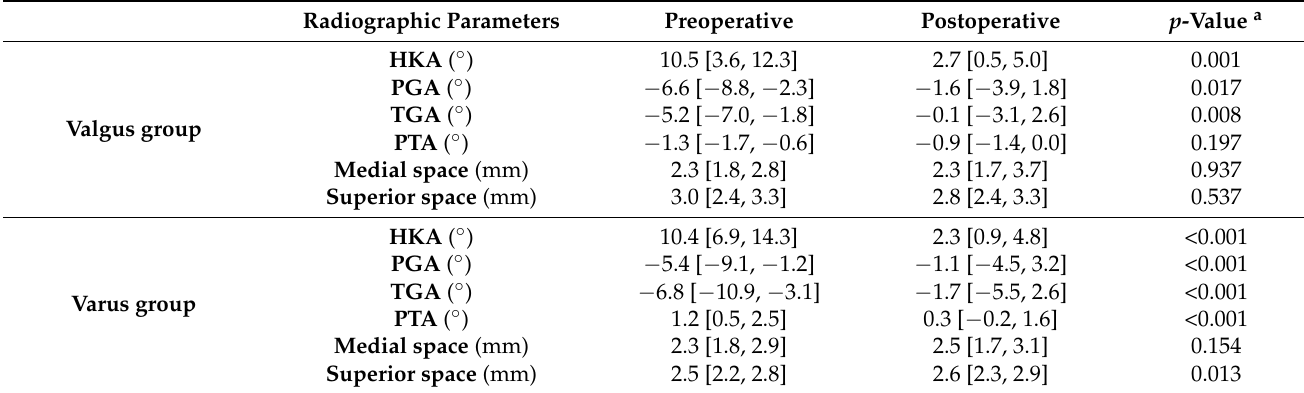
Table 2. Preoperative and postoperative changes in radiographic parameters.